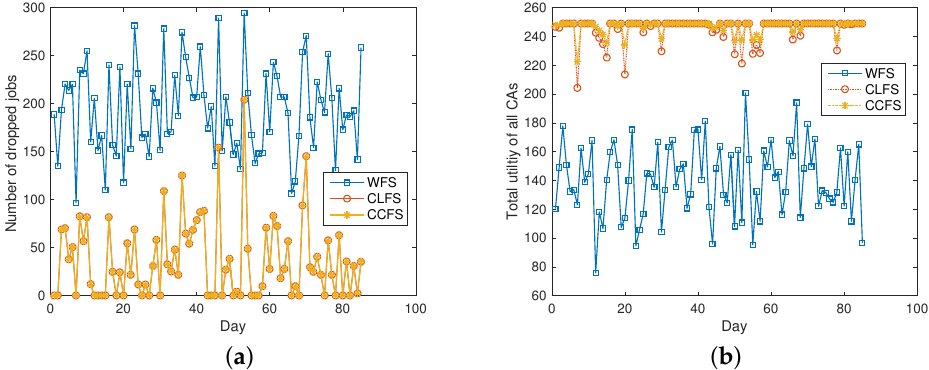
Figure 5. One-thousand-player scenario ( λ i is generated in interval [50, 120], and µ i is generated in interval [50, 100] randomly). ( a ) The numbers of dropped jobs under the three solutions; ( b ) the utility under the three